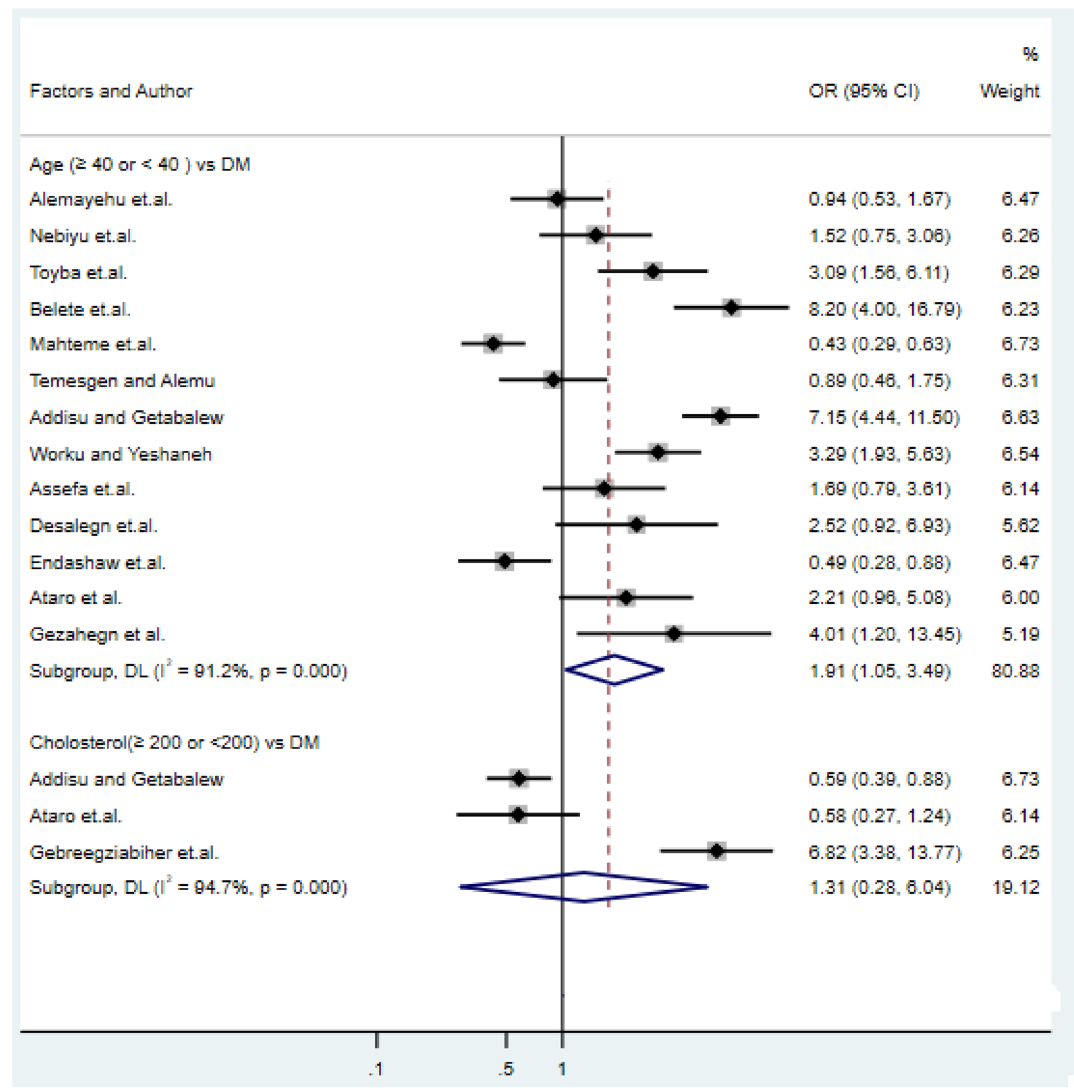
Figure 4. Forest plots of odds ratio for the association age and cholesterol with type-2